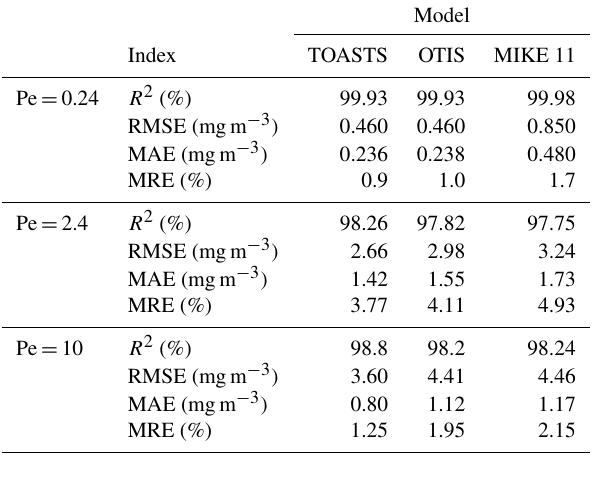
Table 7. Simulation parameters related to test case 2.